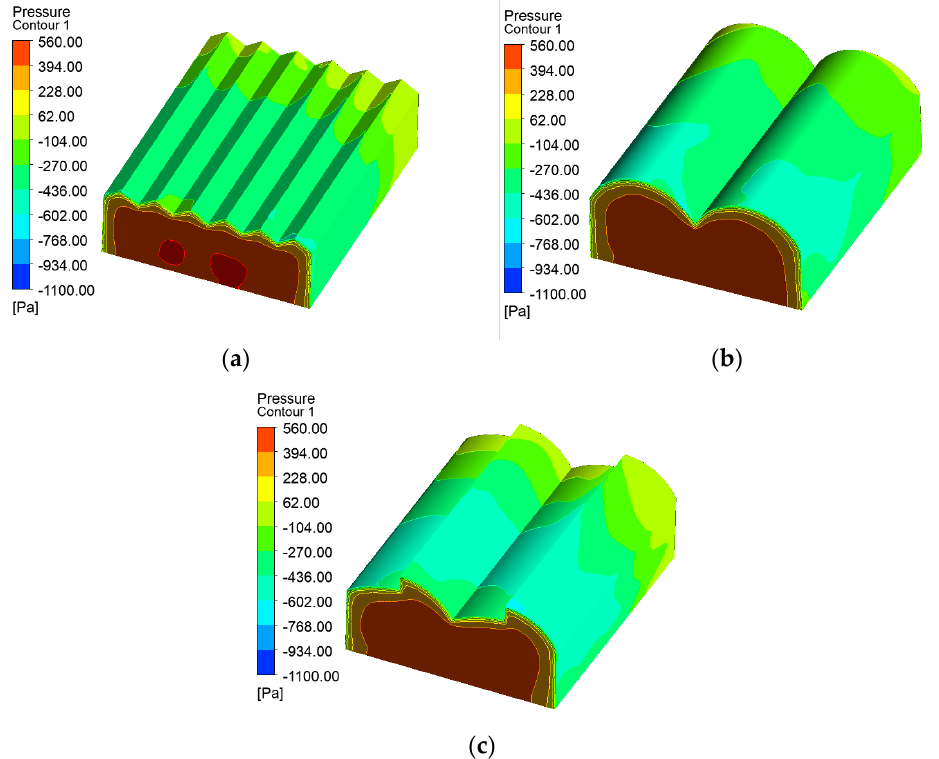
Figure 9. Counters of wind pressure distribution on the greenhouse surface in 90°-wind. ( a ) Venlo Type ( b ) Round-arch Type ( c ) Saw-tooth Type.